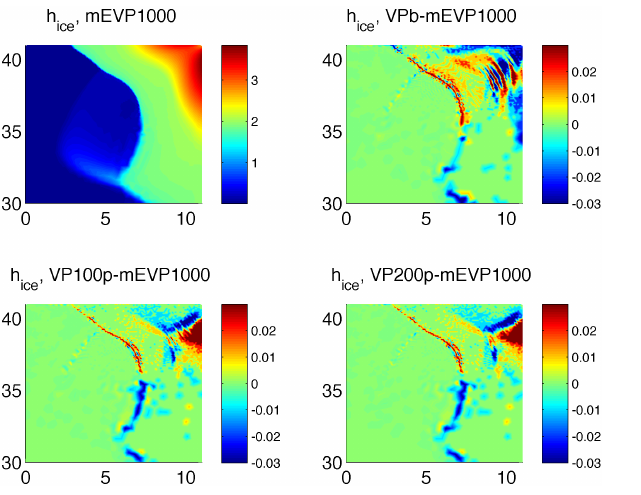
Figure 6. Ice thickness (m) after 1 month of simulations in case C ( (cid:49) min = 2 × 10 − 11 s − 1 ) in mEVP1000 (top left) and differ- ences between the solutions obtained by different methods: VPb- mEVP1000 (top right), VP100p-mEVP1000 (bottom left) and VP200p-mEVP1000 (bottom right). The differences are small and additional Picard iterations only slightly change them.